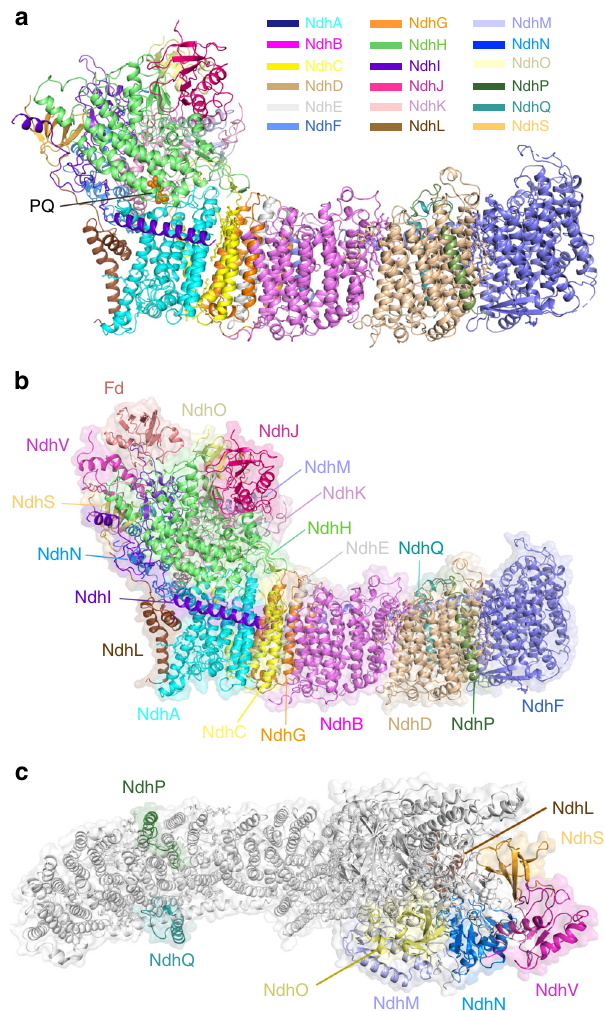
Fig. 1 The NDH-PQ and NDH-Fd structures. a Cartoon representation of the NDH-PQ structure viewed along the membrane plane. PQ is shown as orange spheres and indicated. b The overall structure of NDH-Fd viewed along the membrane plane. c The location of OPS subunits in NDH-1L complex. The eight OPS subunits are colored differently and indicated, while other subunits are shown in